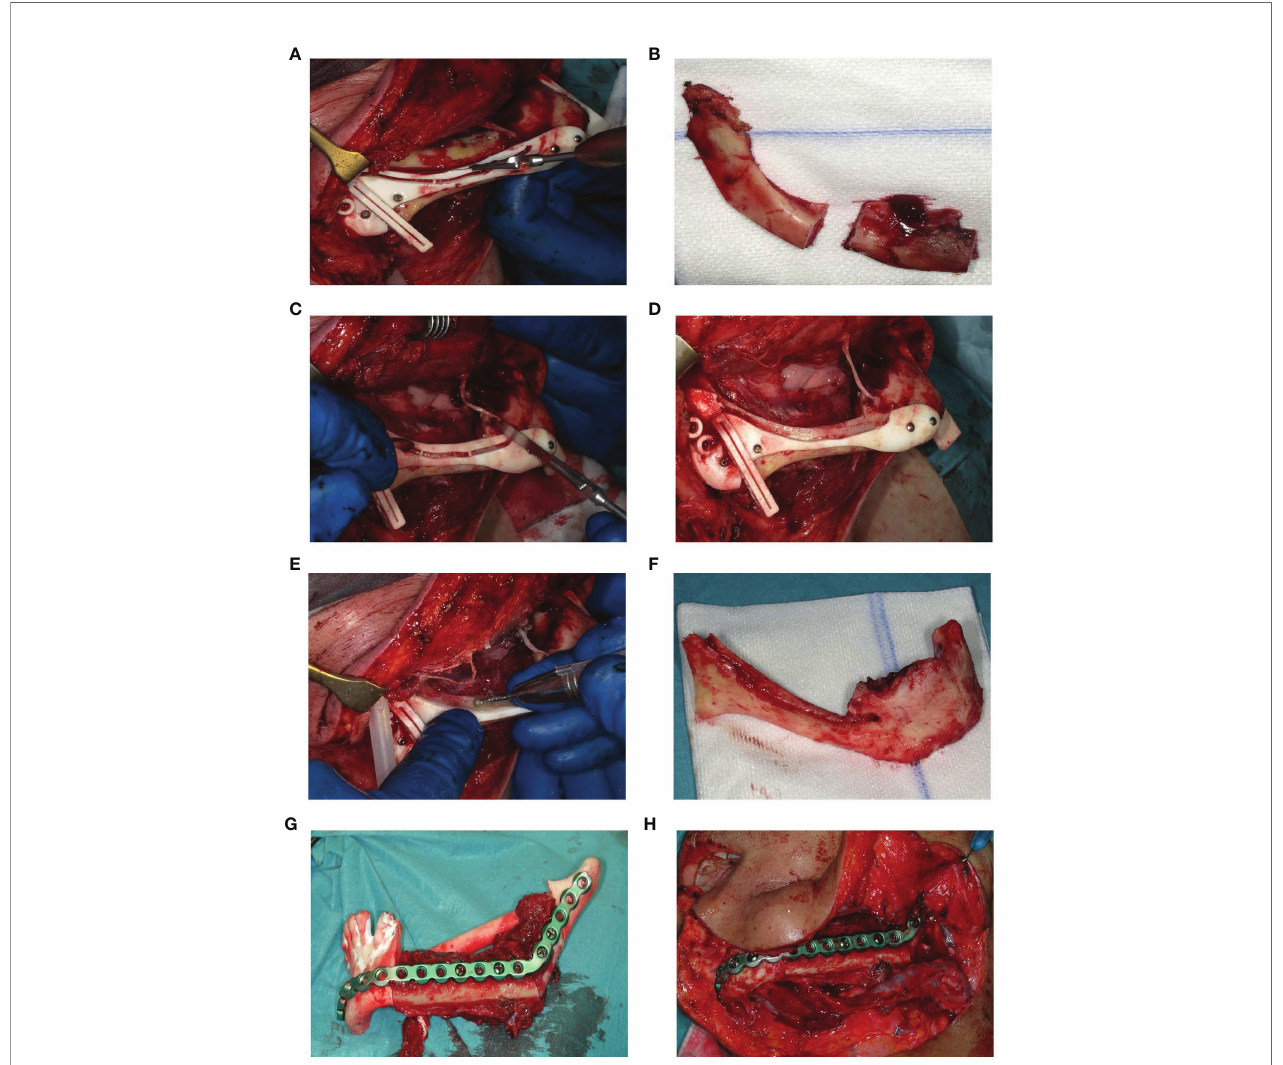
FIGURE 6 | (A) Deroo fi ng of the upper part of the mandible. (B) Removed upper part of the mandible after two vertical osteotomies on both sides. (C) Removal of the upper part of the guide. (D) Accessible buccal bone and 2 mm roof of the IAN. (E) Buccal corticotomy to expose the IAN. (F) Resected part of the mandible without the right IAN. (G) Fitting of the fi bula segments fi xated to the patient speci fi c reconstruction plate into a 3D printed mandible including the planned resection. (H) Reconstruction in situ